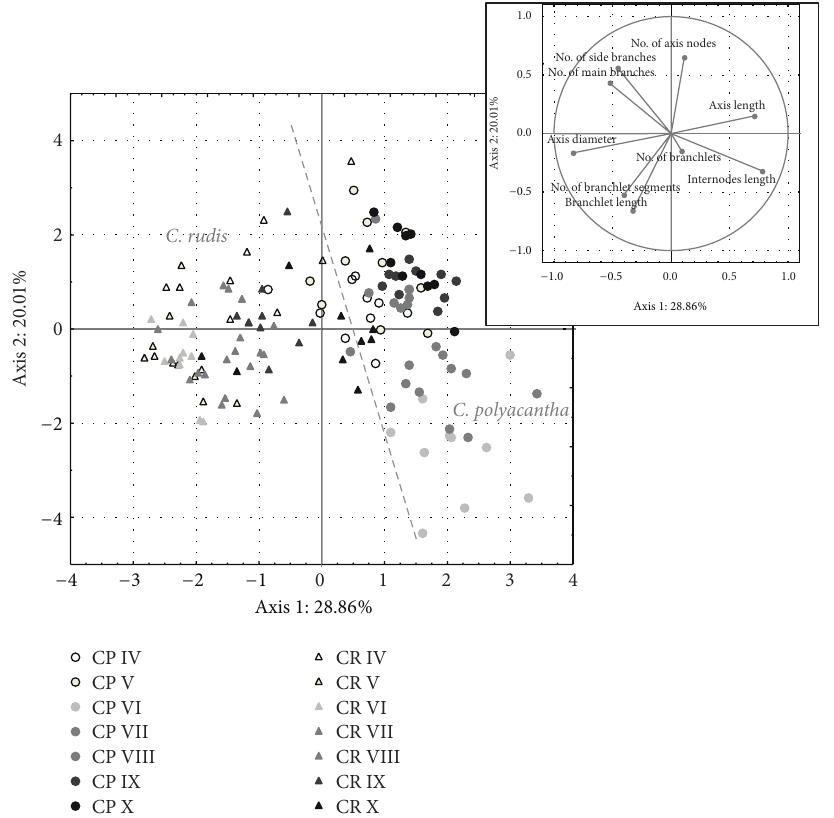
Figure 4: The Principal Components Analysis (PCA) of individuals of both studied species (CP: C. polyacantha site, CR: C. rudis site)— differentiation across morphological characteristics. The roman numbers mean the months of study. Dashed grey line defines the approximate limit of morphological variability of the species.